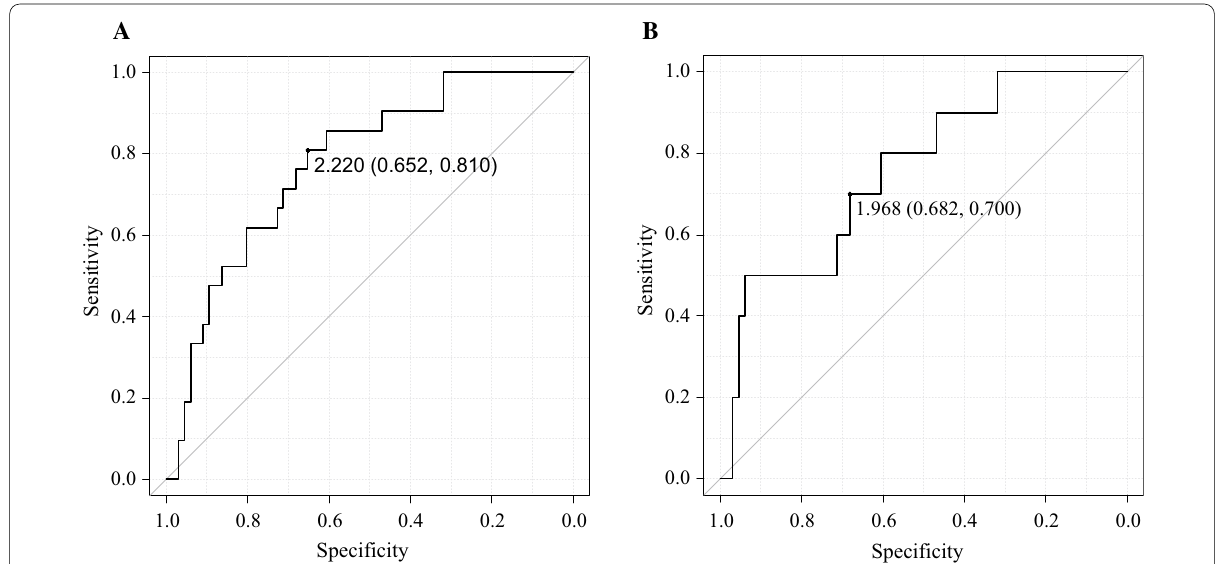
Fig. 2 a ROC curve of FMISO PET for differentiating IDH1 -wildtype tumors from IDH1 -mutant tumors in all malignant gliomas ( n 87). The area = under the curve (AUC) of the FMISO TBR was 0.777 (95% CI 0.669–0.885). When the cutoff value for the FMISO TBR in the ROC curve was set at 2.22, the sensitivity for the differential diagnosis was 81.0%, and the specificity was 65.2%. b ROC curve of FMISO PET for differentiating IDH1 -wildtype tumors from IDH1 -mutant tumors in malignant astrocytomas ( n 76; 18 AAs and 58 GBMs). The AUC of the FMISO TBR was 0.758 (95% CI 0.598– = 0.917). When the cutoff value for the FMISO TBR in the ROC curve was set at 1.968, the sensitivity for the differential diagnosis was 70%, and the specificity was